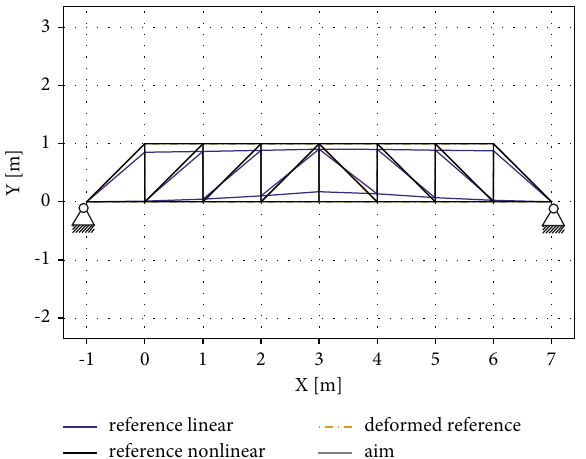
Figure 14: Bridge confgurations in x − y plane for z � 0.